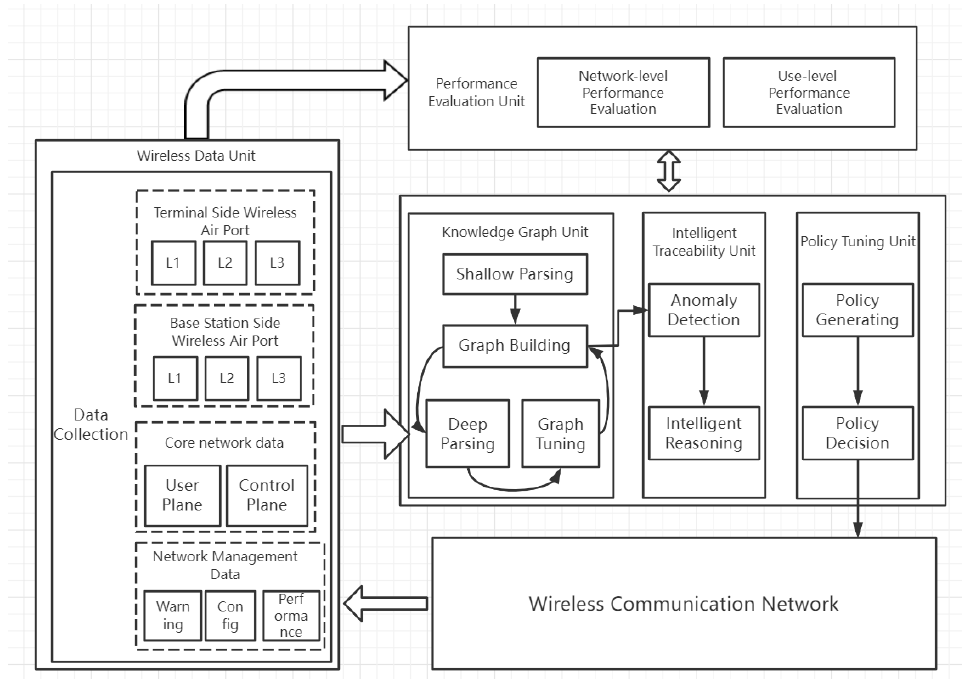
Figure 12. The application architecture of wireless communication network knowledge